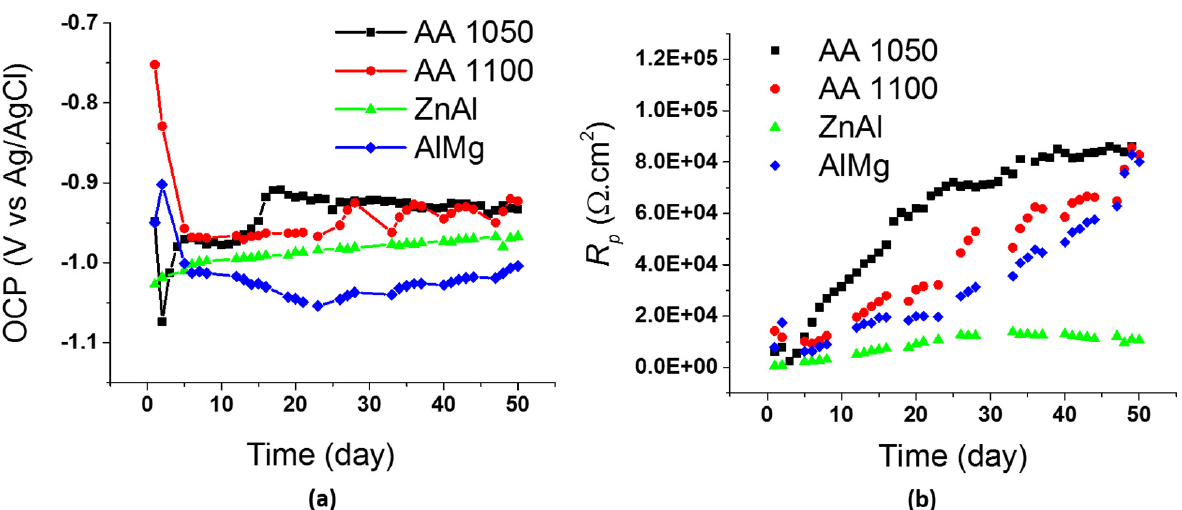
Figure 5. Electrochemical monitoring of long-term performance of TS coatings in artificial seawater by ( a ) OCP (Open Circuit Potential) measurements and ( b ) LPR (Linear Polarization Resistance) measurements.